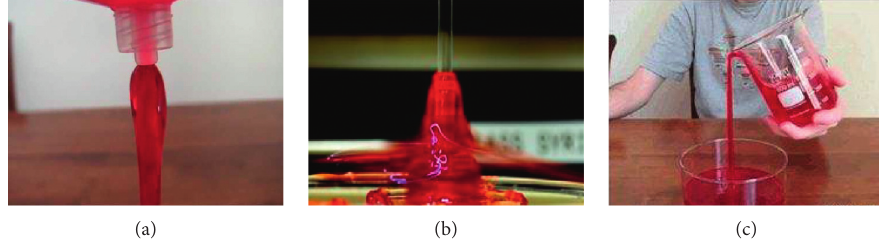
Figure 1: The extraordinary phenomena of viscoelastic fluids. (a) Die swell effect. (b) Rod-climbing effect. (c) Tubeless siphon effect.